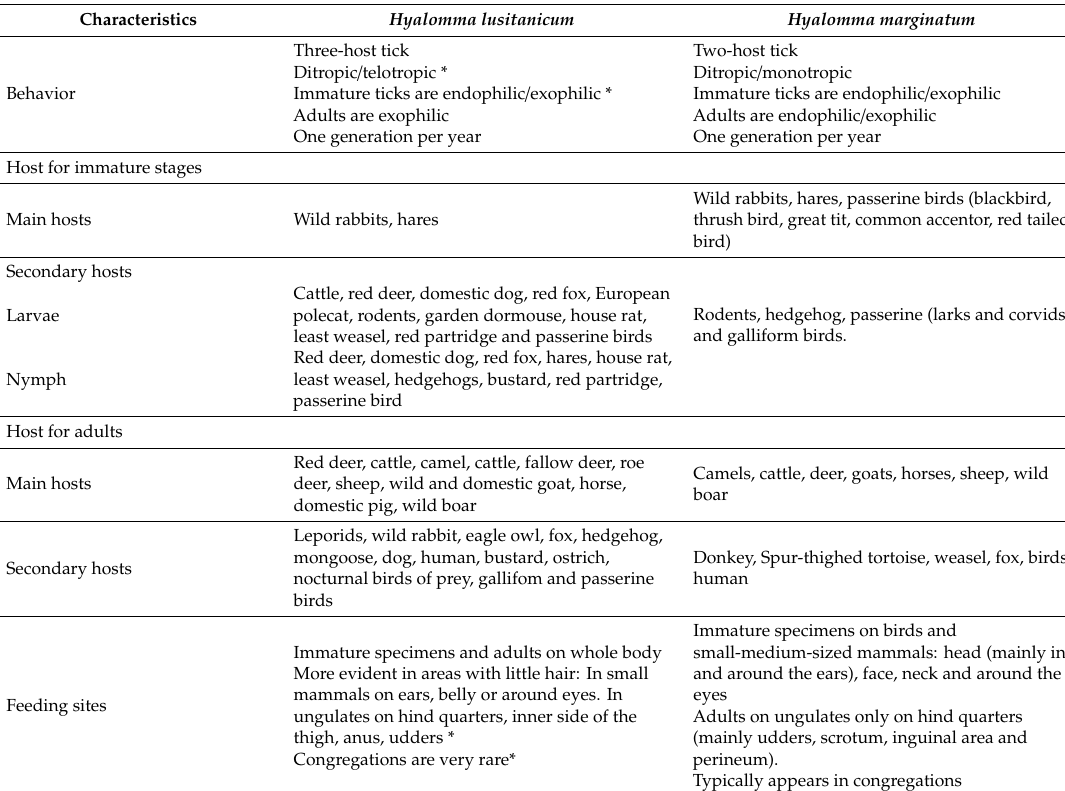
Table 2. General characteristics of the life cycle, main hosts and feeding habits of Hyalomma lusitanicum and Hyalomma marginatum. * Personal